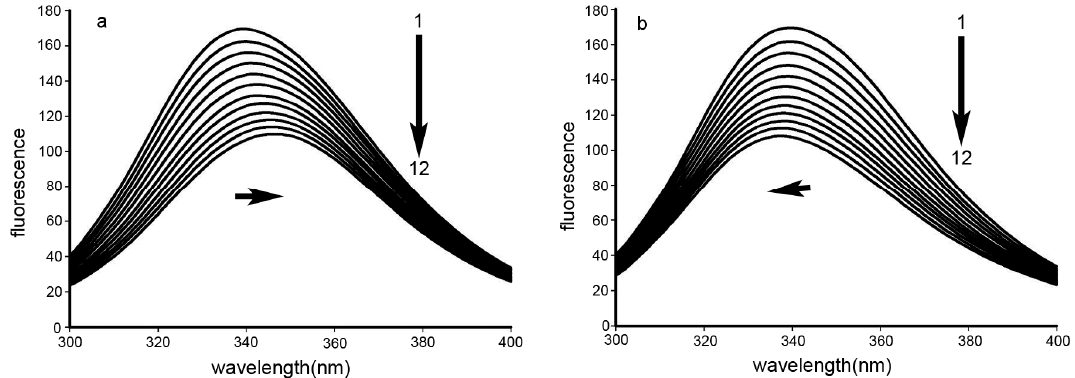
Figure 2. Stern–Volmer plots for the system ( a ) BSA-DPPCAH and ( b ) BSA-DPPCAH-Cu, C BSA = 1.0 × 10 − 5 (M); pH = 7.2, at 288 K.